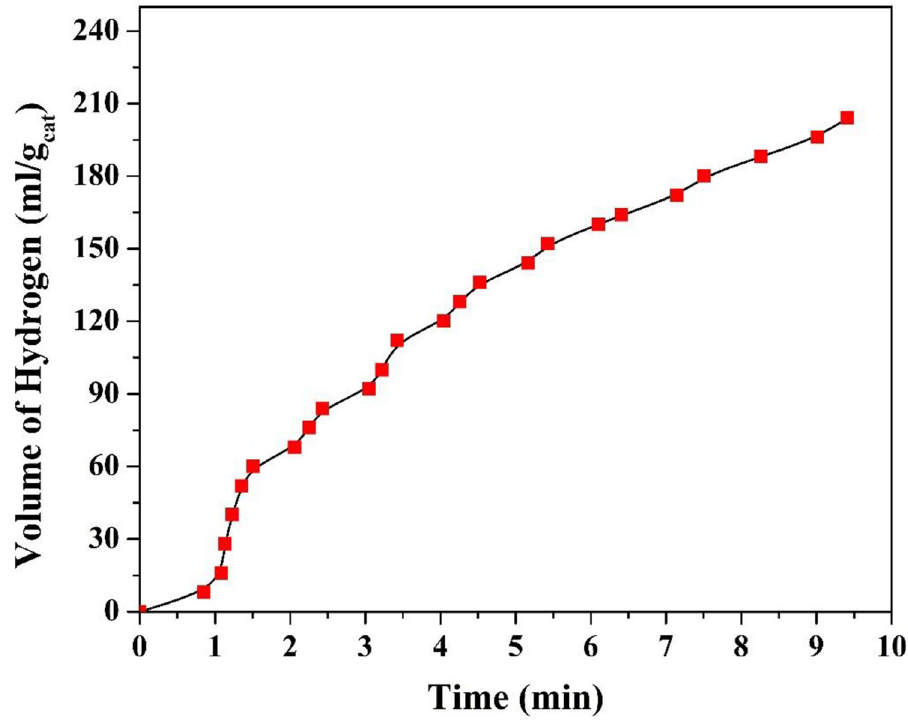
Fig 9. Hydrogen production rate using 0.5% Cd nanofiber sample at 25 ˚C without using a